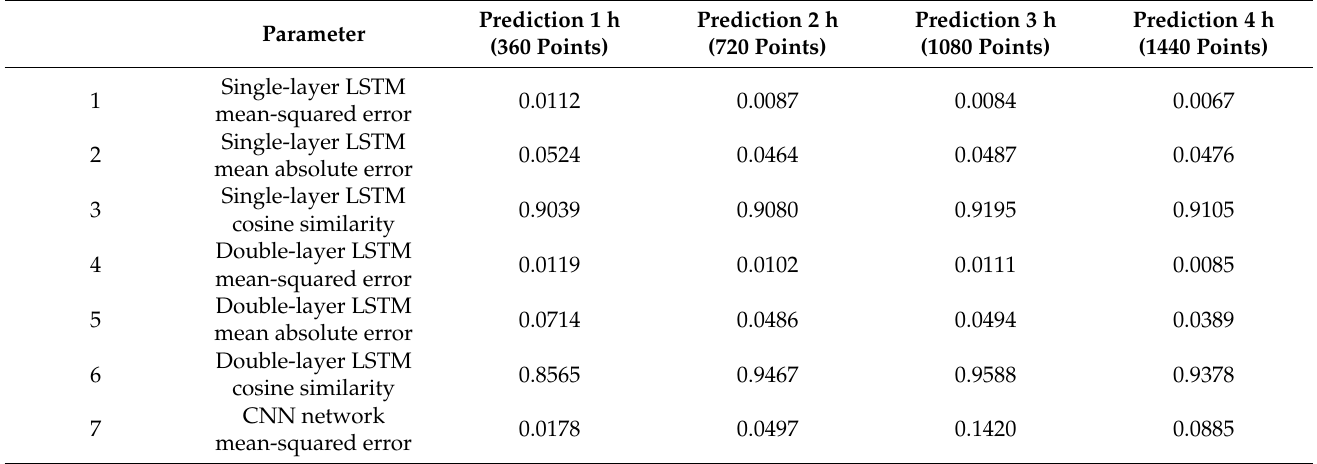
Table 4. Comparison of prediction evaluation metrics for performed